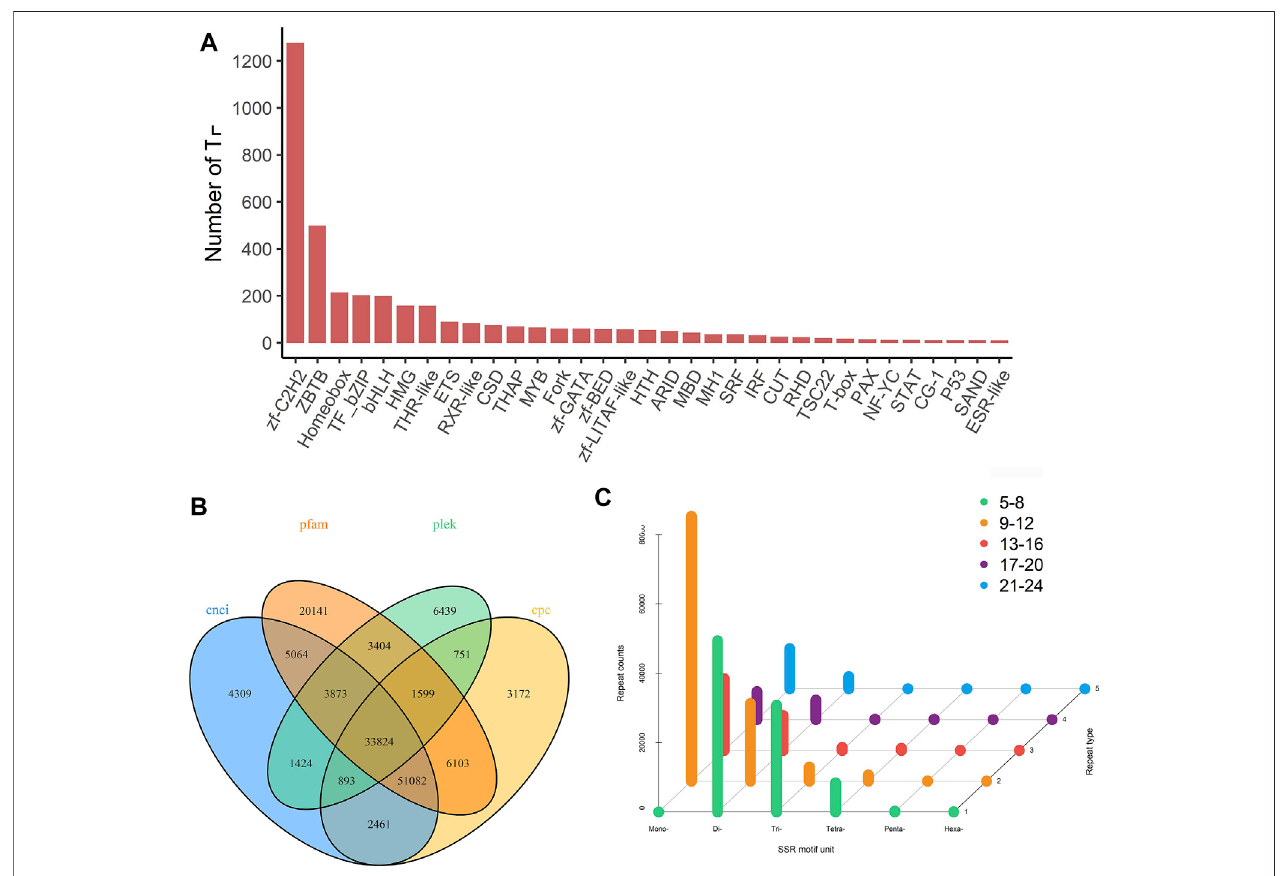
FIGURE 4 | Prediction of transcription factors, long-non-coding RNAs and SSR of gonadal transcripts. (A) Transcription factor statistic. (B) Venn diagram of the number of lncRNAs predicted by CNCI, CPC, PLEK, and pfam protein structure domain analysis. (C) Prediction of SSR by MISA.